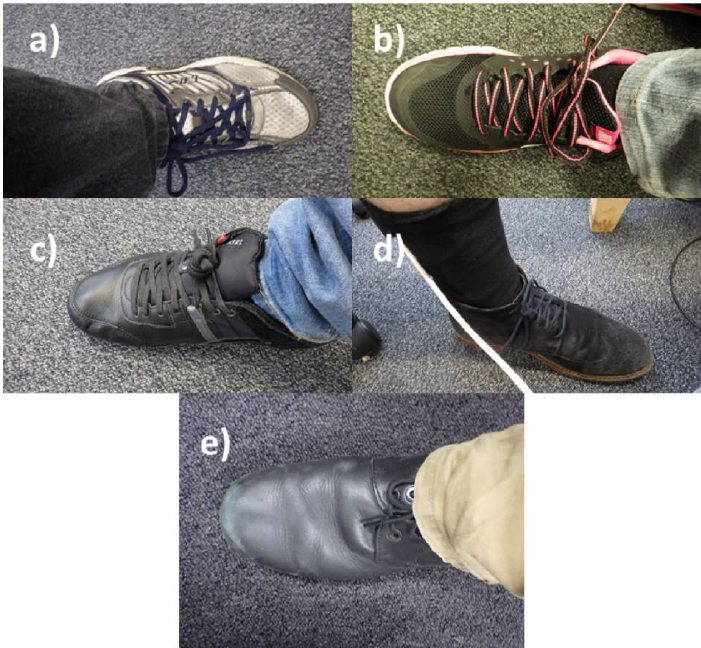
Figure 4. The shoes worn by the five volunteers for the trial. Different types of common footwear were used. The shoes worn by ( a ) Volunteer 1, ( b ) Volunteer 2, ( c ) Volunteer 3, ( d ) Volunteer 4 and ( e ) Volunteer 5.